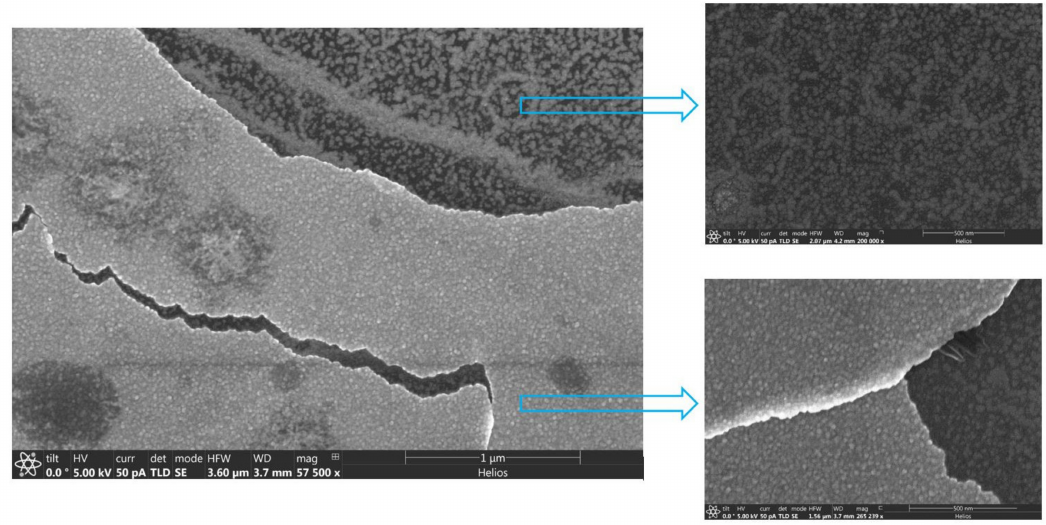
Figure 2. SEM image of the surface area of the bismuth ferrite (BFO) / HOPG structure, the enlarged area on which the delamination of the BFO film from the substrate is